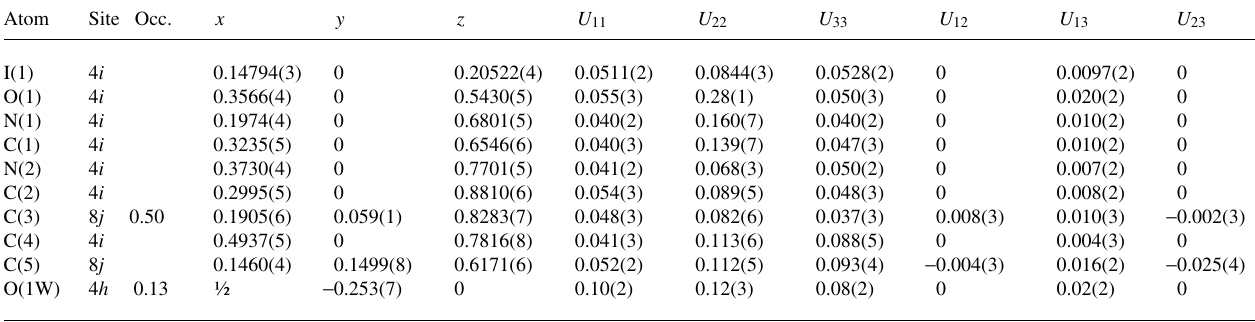
Table 3. Atomic coordinates and displacement parameters (in Å 2 ) .